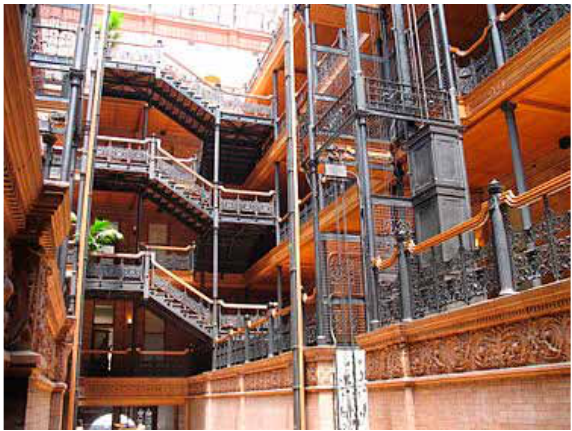
fig. 11. Interior view of the Bradbury Building